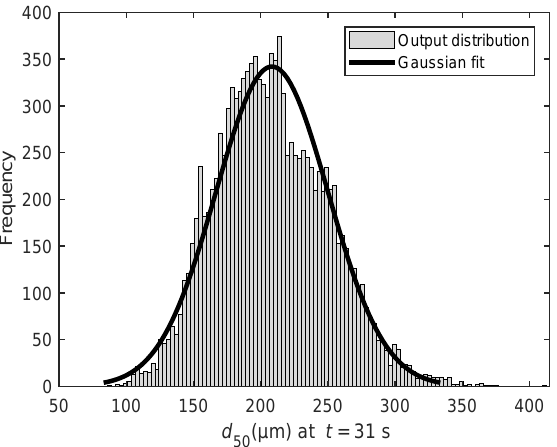
Figure 3. Distributions of d 50 value at 31 s simulated from the Monte Carlo method using 12,000 samples. The solid line shows the fit of a normal distribution to the histogram.